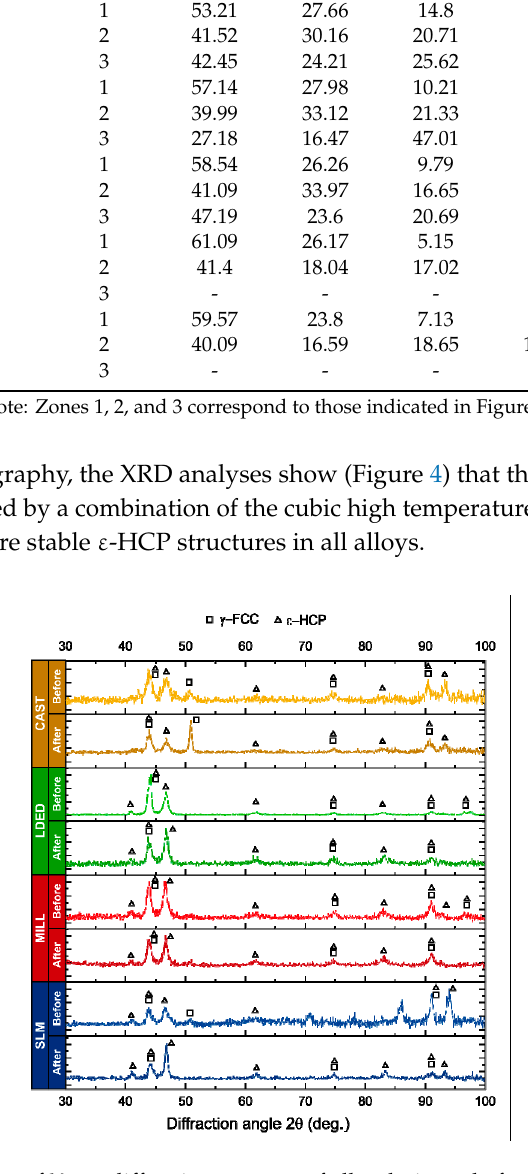
Figure 4. Comparative of x-ray diffraction patterns of all techniques before and after PFM firing.